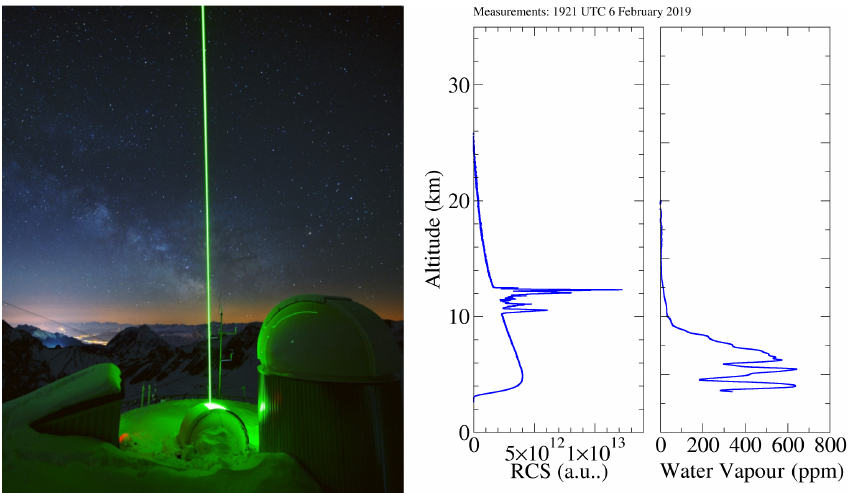
Figure 3. Lidar measurements at the Schneefernerhaus station. The plot shows an example of the range-corrected signal (RCS) of the backscatter lidar, detecting a cloud layer, and the water vapour profile of the Raman lidar measured on 6 February 2019, 19:21UTC.